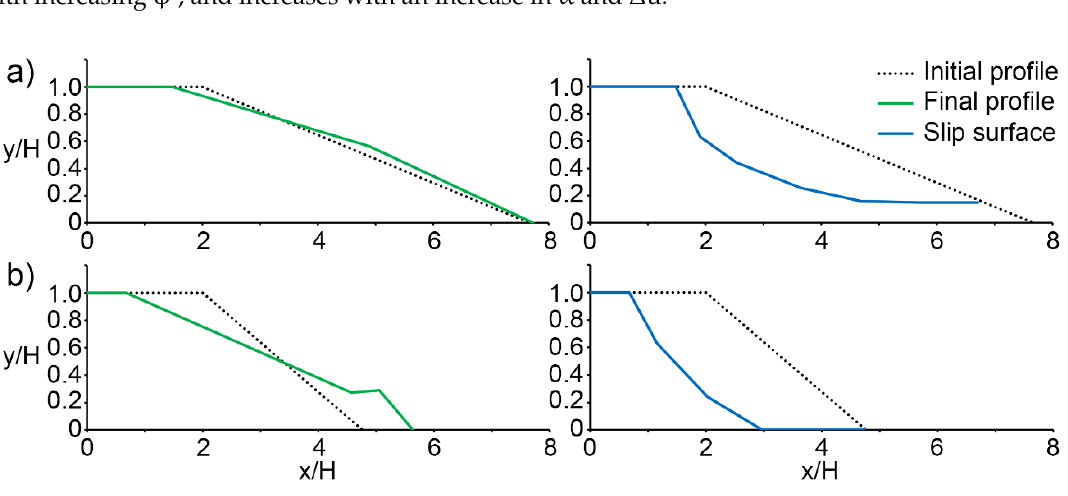
Figure 10. Location of the slip surface in dimensionless coordinates, for the case with α = 15°, φ’ = 35° , and different values of Δu.